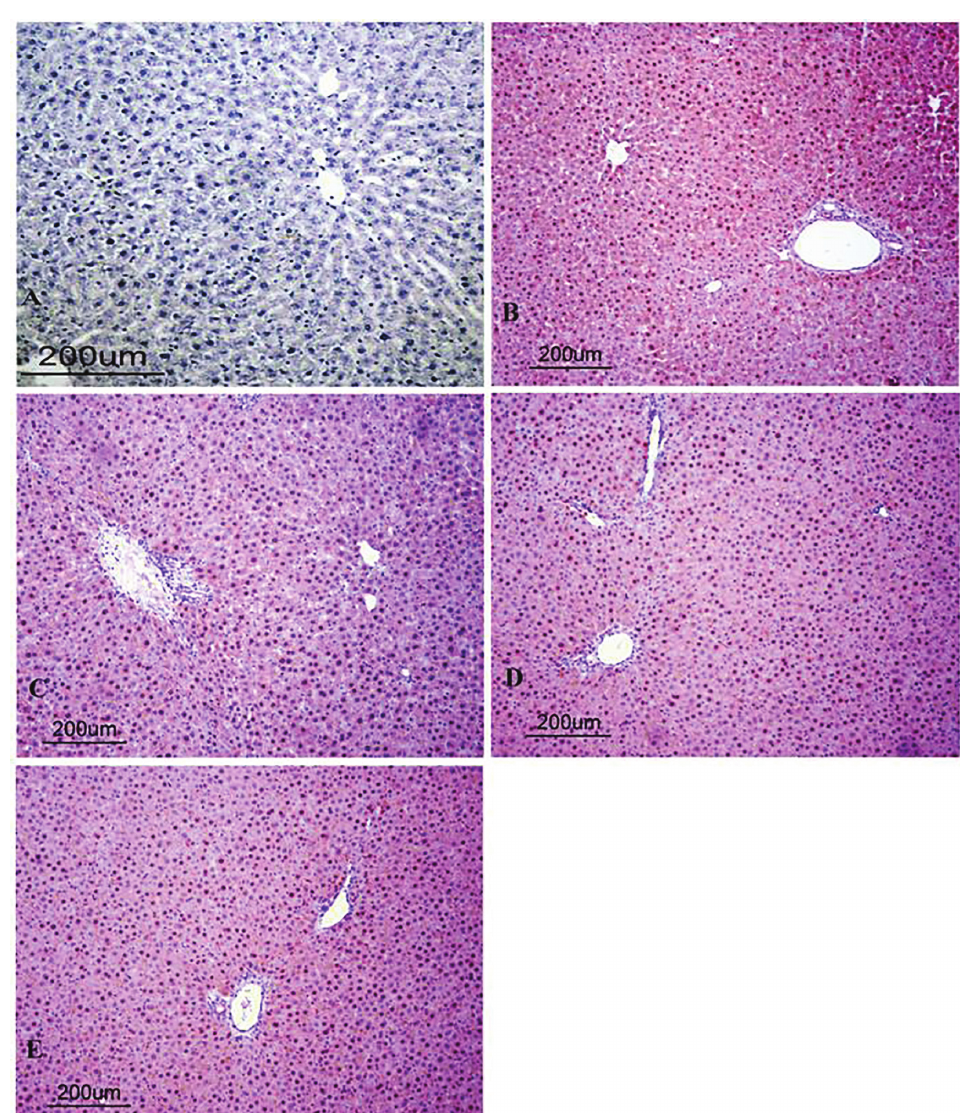
FIGURE 3 - Microscopic appearance of the degree of staining according to the immunoperoxidation method of GPx1 reactivity of the liver cells. A; negative control group, B; control group, C; IR group, D; IR+UDSE group, E; UDSE TABLE II - Comparison of the 8-Hydroxy-2’-Deoxyguanosine/ 10 6 deoxyguanosine rates among the groups